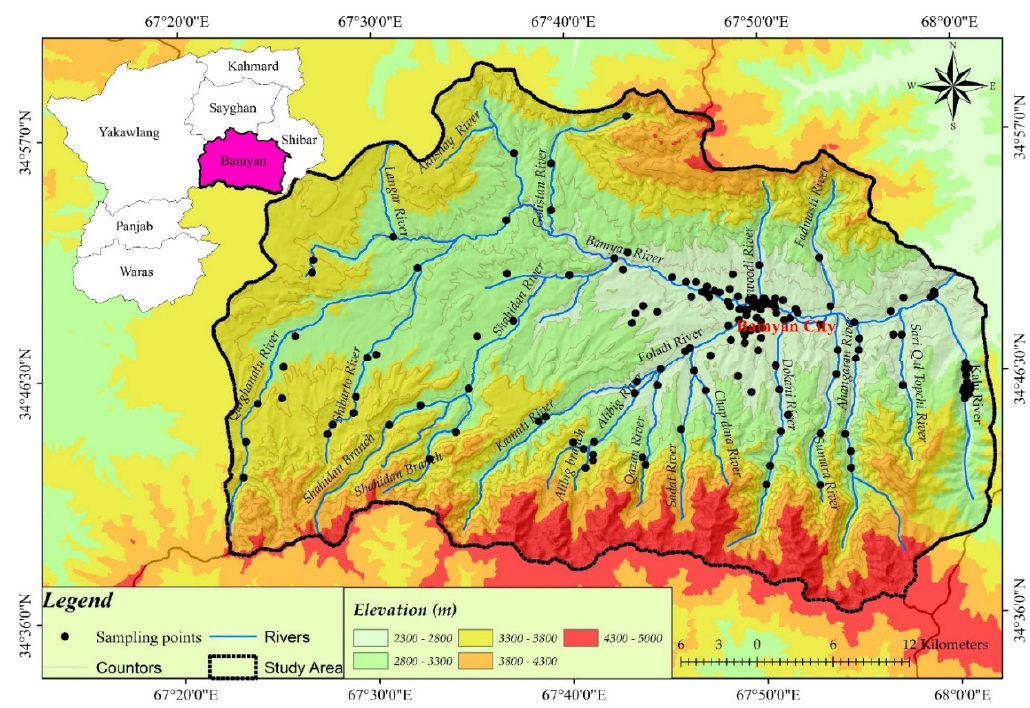
Figure 1. Study area in Bamyan Province, main surface water sources (rivers and springs), and locations of measurement points in Bamyan Valley.